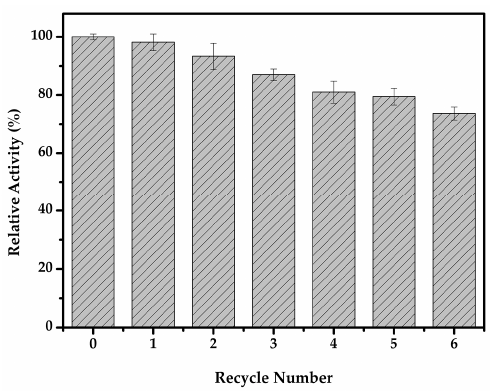
Figure 8. The carboxylmethyl cellulose (CMC) reusability of the immobilized cellulase.